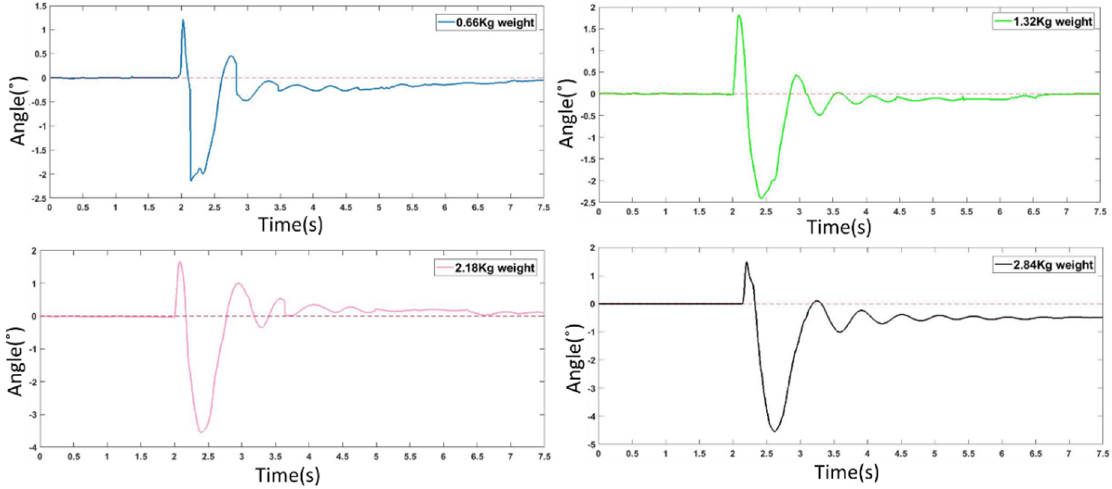
Figure 19. Stability experiment under impact of external heavy objects.